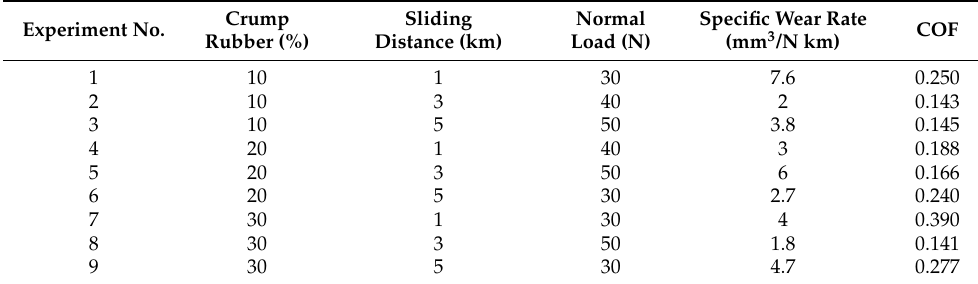
Table 3. Experimental matrix and recorded response